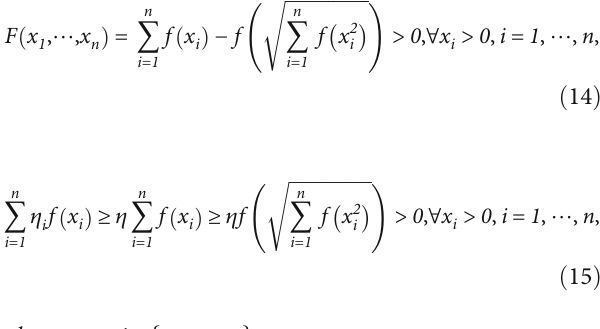
= η = 2, 4, 6, 8 are 1 2